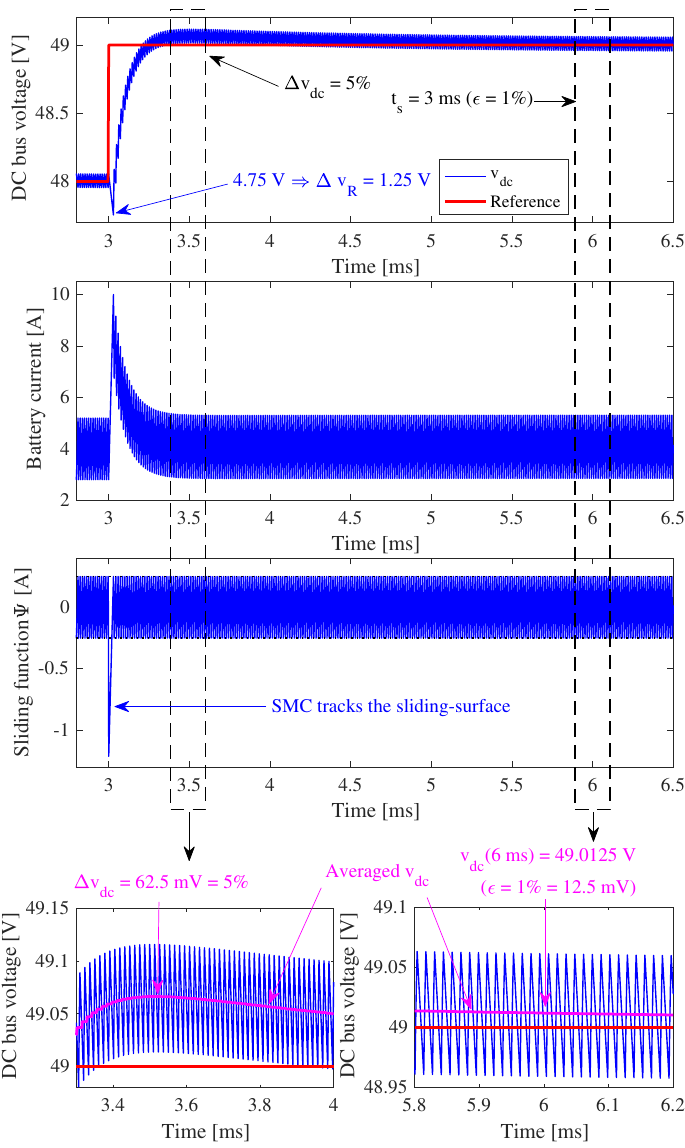
Figure 15. Simulation of the proposed SMC with changes in the